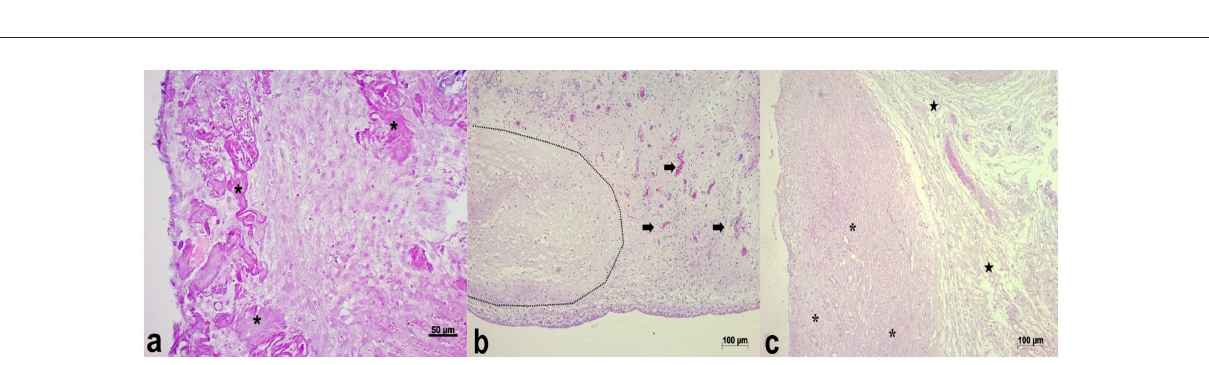
revealed that the presence of multifocal multinucleated cells differed between groups at 7 (G1 > G2) and 21 (G2 > G1) days after surgery ( p